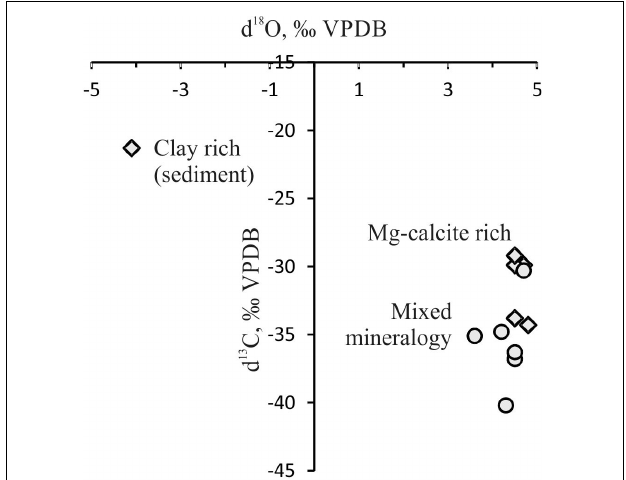
FIGURE 9 | Stable carbon and oxygen isotope compositions of crusts: circles, samples OD-I-2 and OD-I-3; diamonds, samples